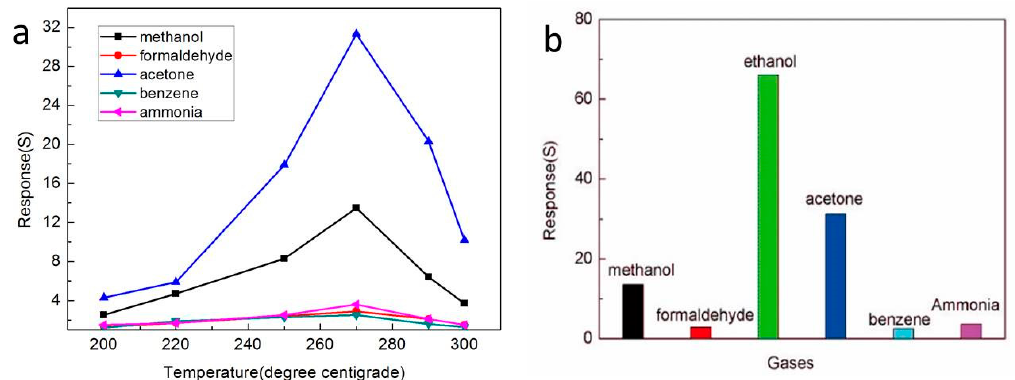
Figure 8. (a) The gas-sensitive characteristics of different sensors for different gases ; (b) The gas sensing response of the In 2 O 3 -8 h sensor to different gases.